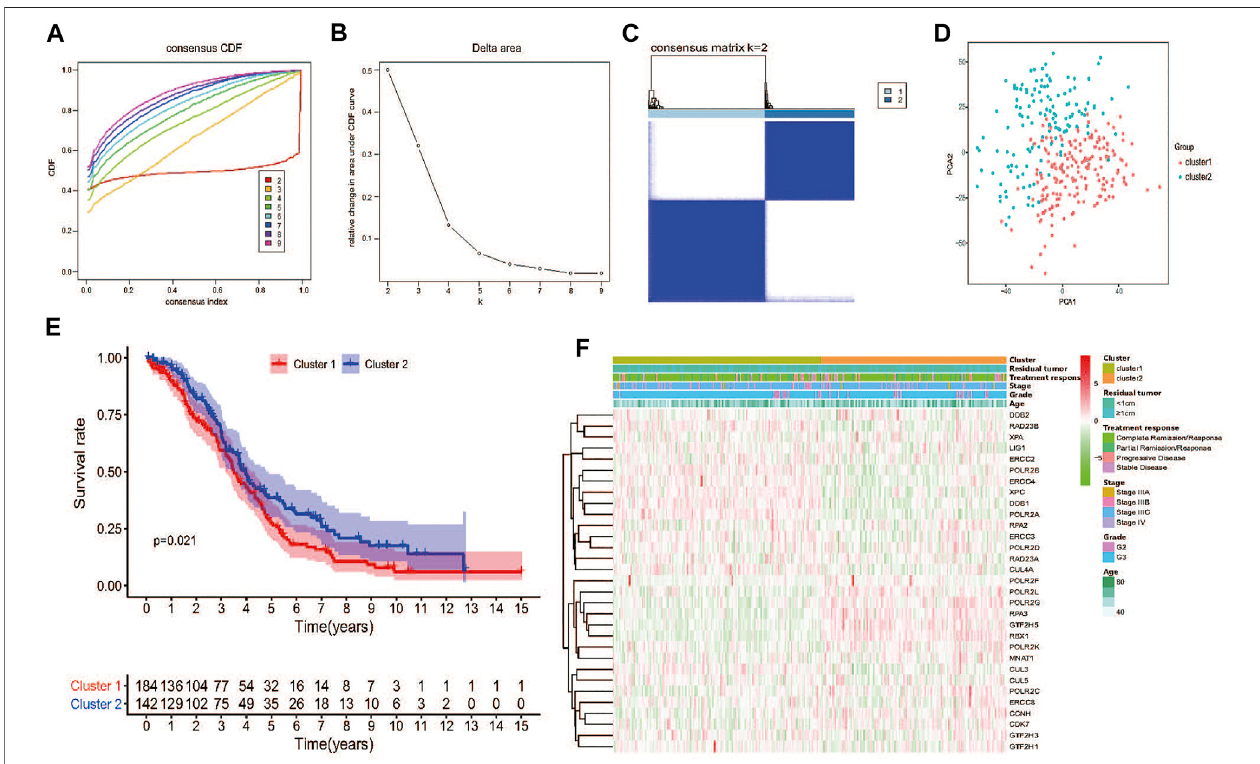
FIGURE 3 | Consensus clustering and overall survival of TCGA HGSOC patients in the different two clusters. (A) Consensus clustering CDF for k = 2 to 9. (B) RelativechangeinareaunderCDFcurvefork=2to9. (C) TheTCGAHGSOCpatientswasdividedintotwodistinctclusterswhenk=2.Consensusclusteringmatrixfor k=2. (D) PCAofthetotalmRNAexpressionpro fi leintheTCGAdataset.HGSOCpatientsinthecluster1subgrouparemarkedwithred,HGSOCpatientsincluster2are marked with green. (E) Kaplan – Meier OS curves for different clusters. (F) No signi fi cant difference was found for the clinicopathologic features between cluster1 and